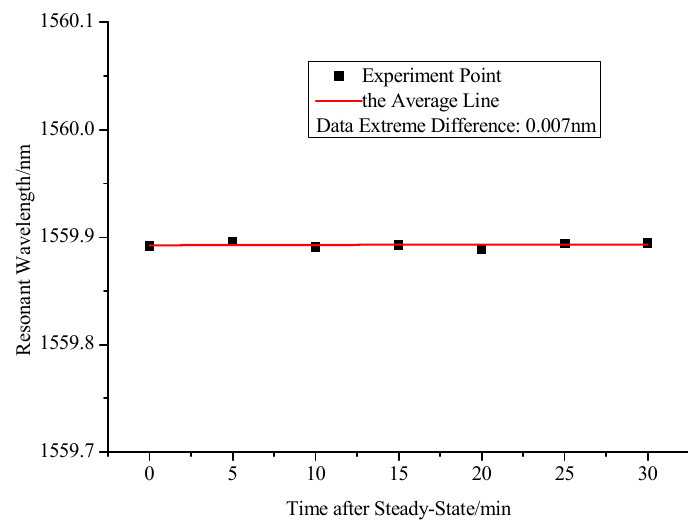
Figure 9. Stability curve of the proposed hydrogen sensor.